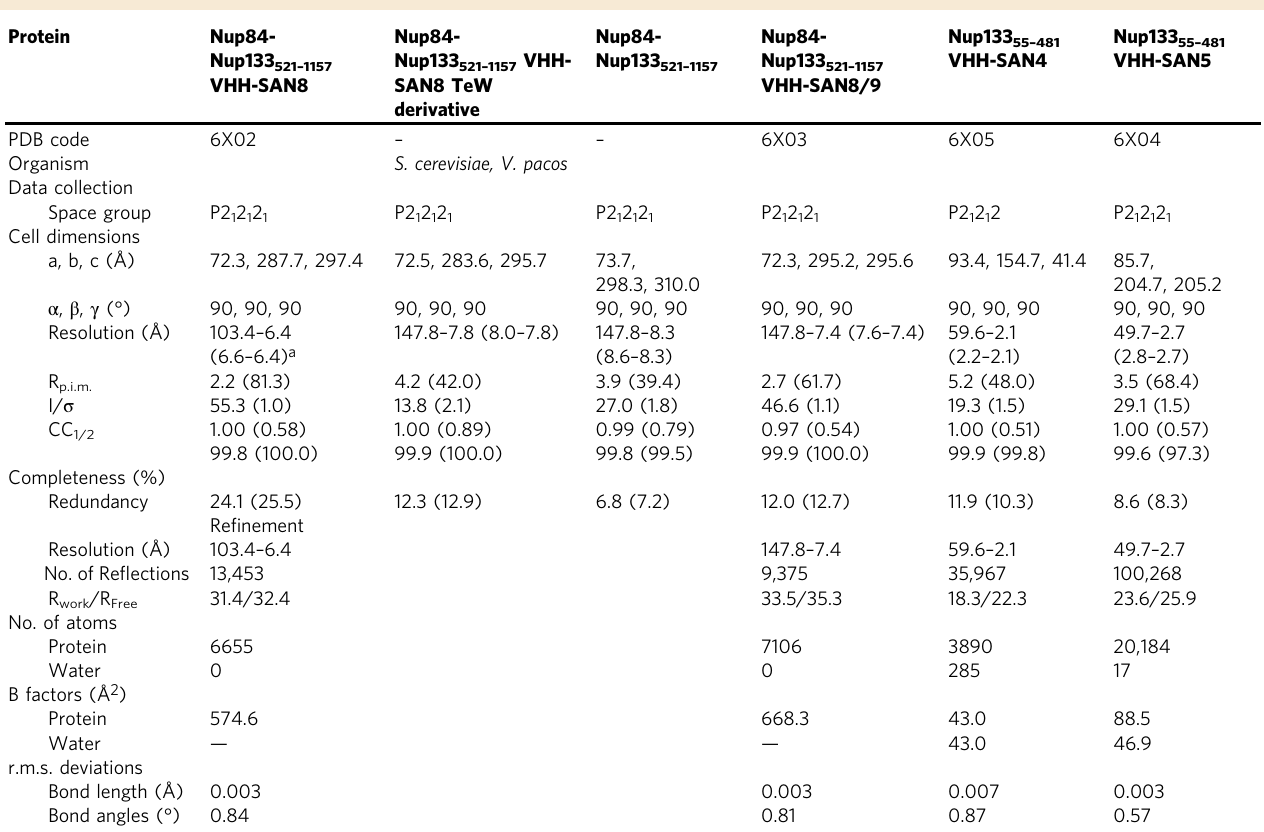
Table 1 Data collection and re fi nement